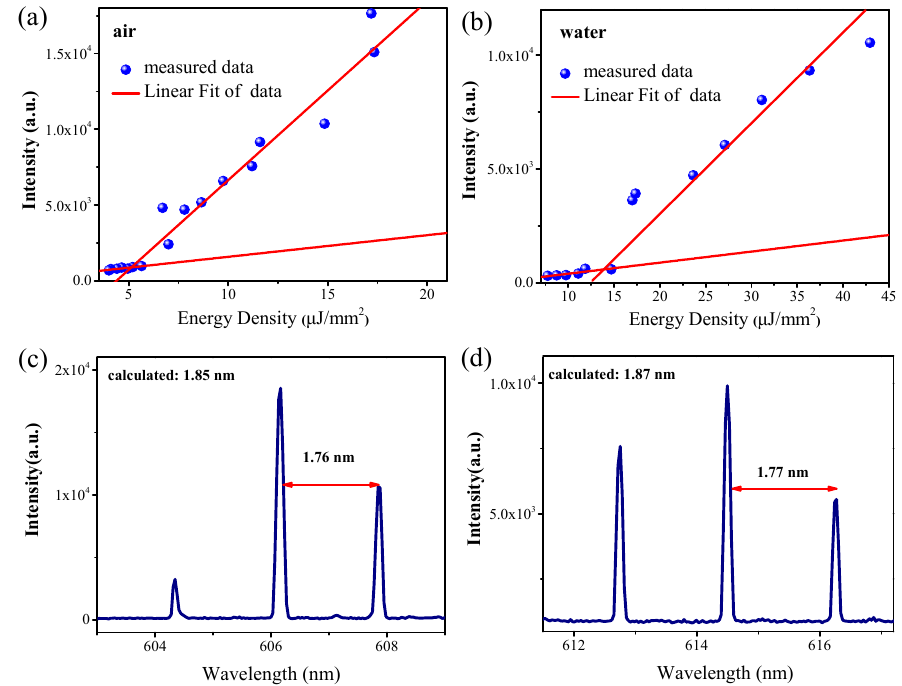
Figure 2. Comparisons of the output laser intensity as a function of the energy density (light-light curve) around the single mode lasing wavelength pumped by ( a ) air objective and ( b ) WIO, respectively. Typical laser spectrum pumped by air objective ( c ) and WIO ( d ), respectively. Calculated free spectral range (FSR) and measured FSR are both denoted.